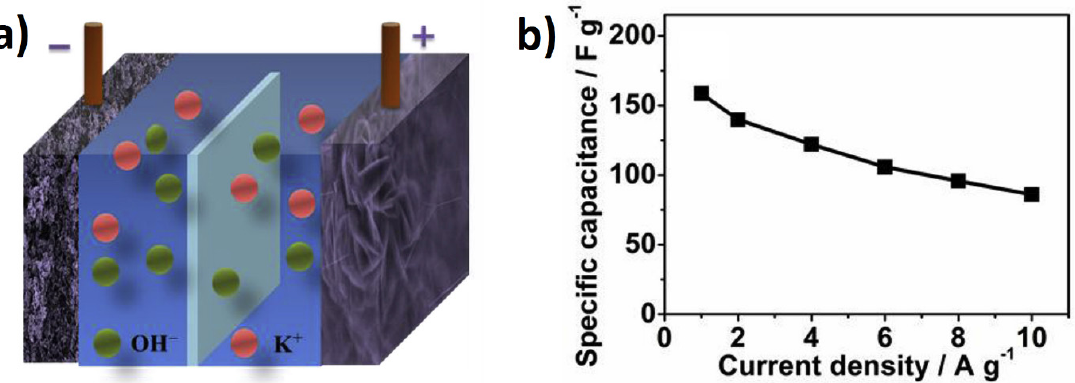
Figure 12. ( a ) Schematic illustration of the assembled hybrid supercapacitor. ( b ) Specific capacitance at different current densities. Reprinted from ref. [69] with permission from Elsevier Ltd. Qin reported the synthesis of a hierarchical nanoporous graphene (hnp-G) with a high specific surface area (1160 m 2 ·g − 1 ) and its performance as a binder-free electrode for flexible solid-state supercapacitors (Figure 13) [70].